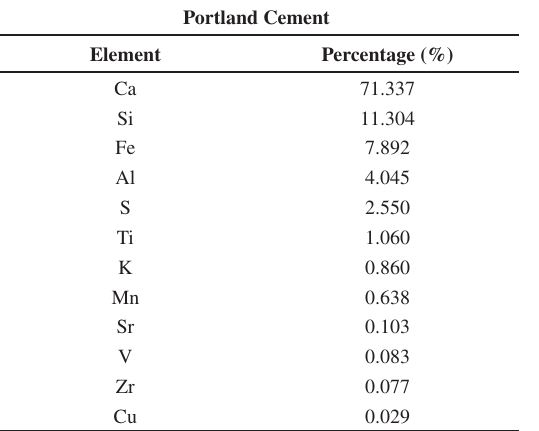
Table 2. Chemical analysis of CP IV-32 RS Portland cement by EDXRF.